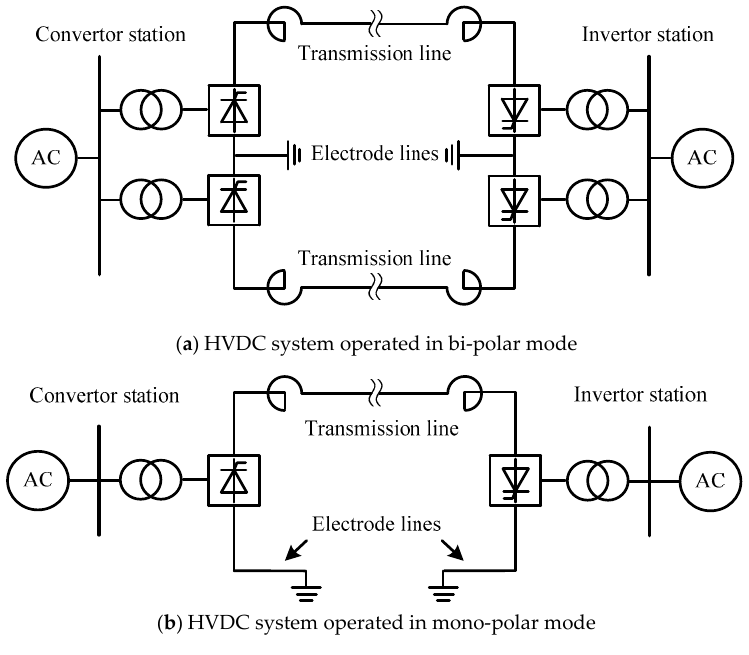
Figure 1. Operation mode of HVDC system.